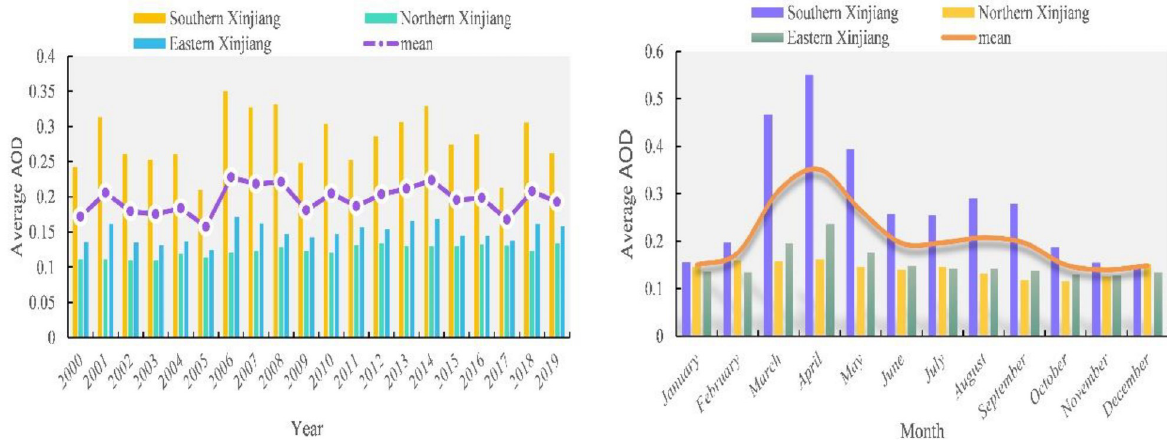
Fig 5. (a)The dynamic alteration of AOD in the research of region from 2000 to 2019, and (b) spatio spread of the mean AOD in different months from 2000 to 2019.